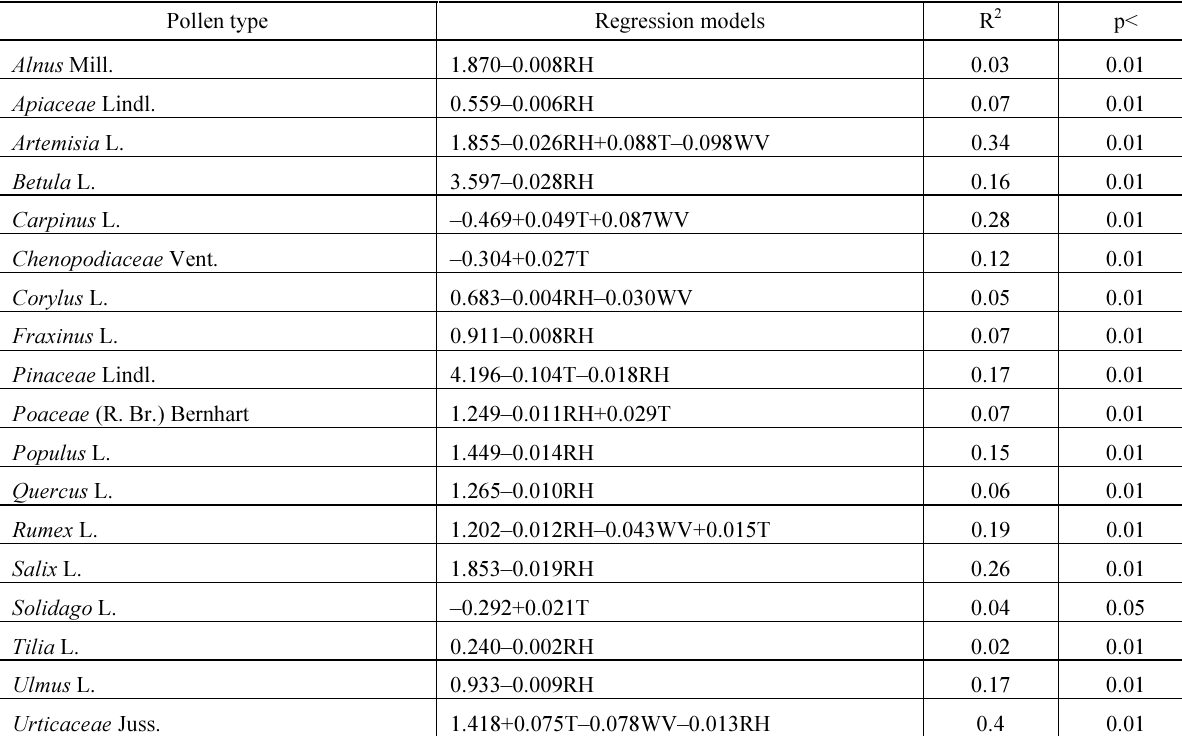
Table 1. Regression models for the pollen seasons of plants genera and families (2004 – 2009) made according to the method of vari- ables inclusion. Variables: T – air temperature, RH – relative air humidity, P – amount of precipitation, WV – wind veloc- 2 ity (R – coefficient of determination, p – level of significance according to Stjudent’s